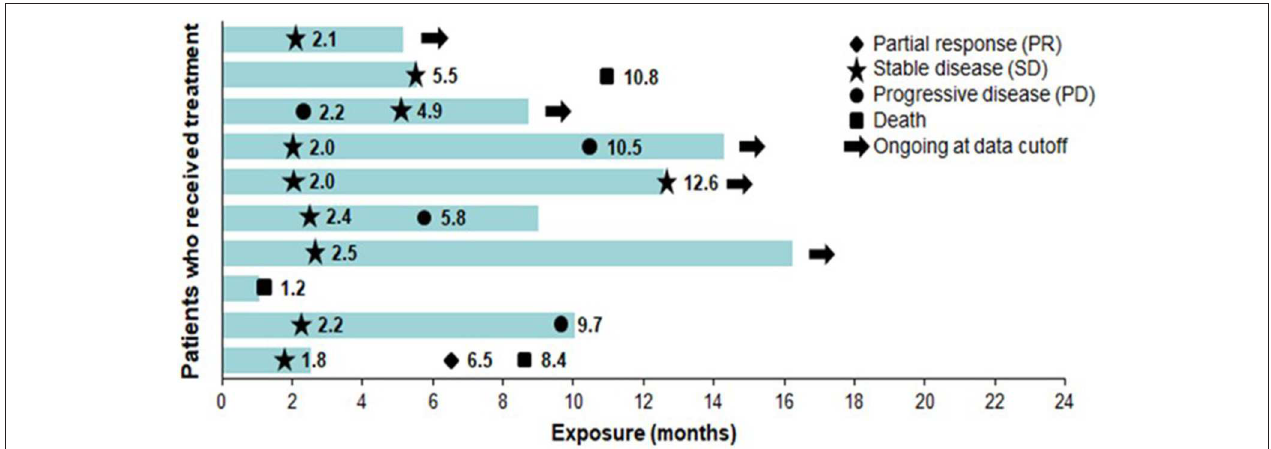
FIGURE 2 | Exposure and response to TTFields + RT + TMZ and TTFields + TMZ maintenance therapy. Each bar represents one patient. Bar length represents study exposure time (months). Marker data labels represent event start since first TTFields dose date. RT, radiation therapy; TMZ, temozolomide; TTFields, Tumor Treating Fields.